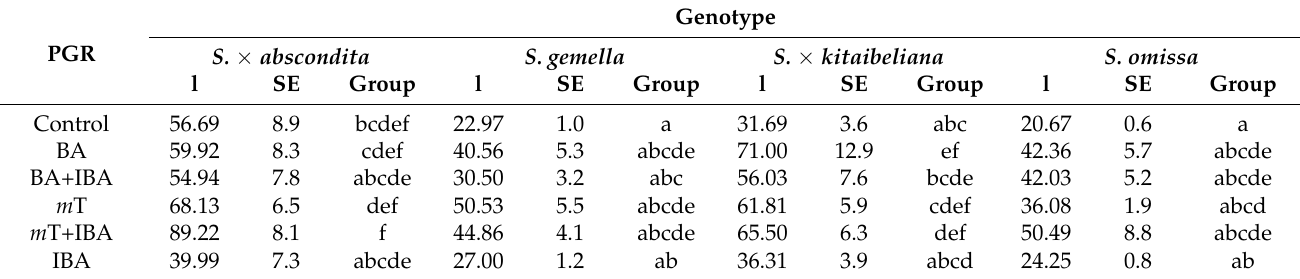
Table 2. The effect of interaction between the genotype and the PGR treatment on the total shoot length in Sorbus species (l). The term SE denotes corresponding standard error; group shows significant differences according to Tukey’s range test ( p -value = 0.05).